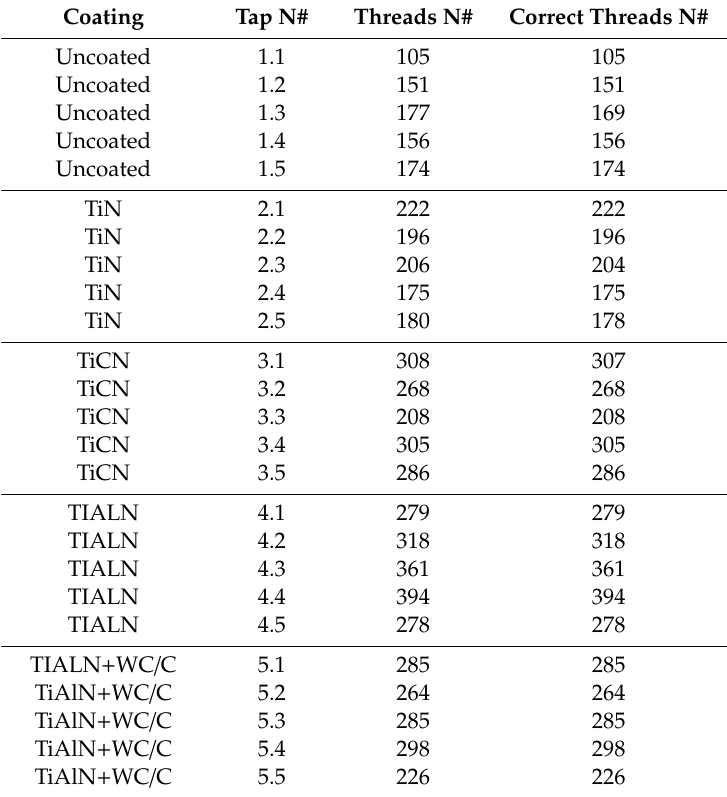
Table 2. Coating, tap reference and total and correct threaded holes